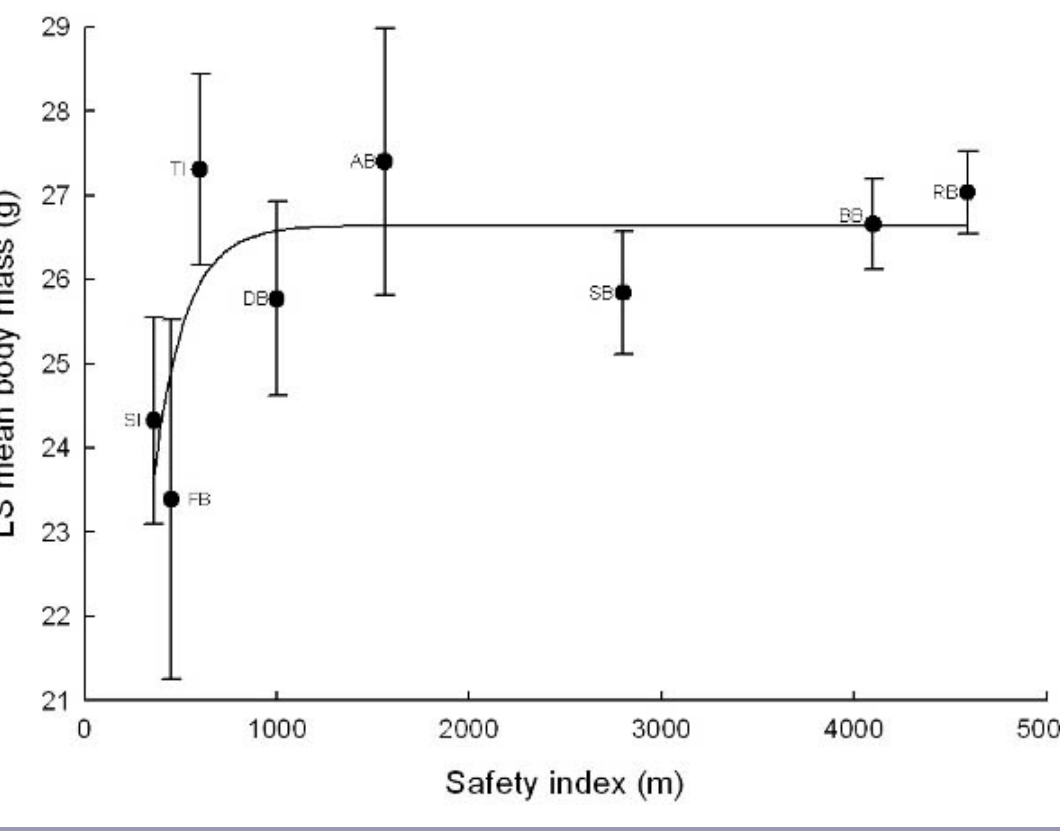
Fig. 3. The relationship between the safety index measured at stopover sites and the least-squares mean body mass (± 95% C.I.) of sandpipers captured. The line is that predicted from the nonlinear